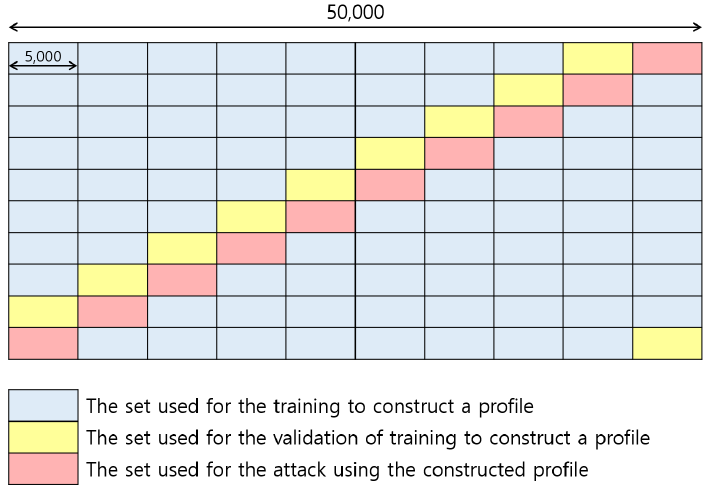
Figure 2. Selection of data for K-fold